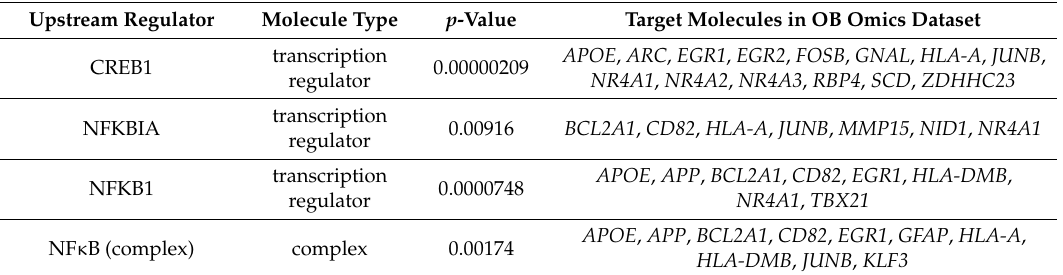
Table 1. Potential upstream regulators of differential targets detected in our